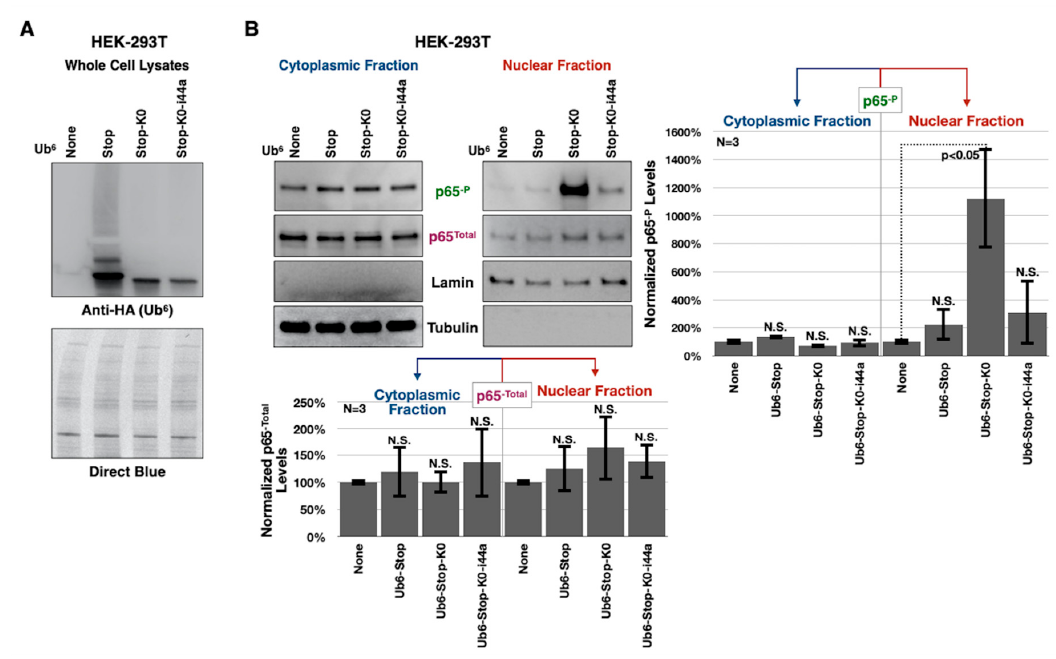
Figure 7. Isoleucine 44 mediates nuclear translocation of phosphorylated p65 in mammalian cells. ( A ) Western blots from whole-cell lysates of HEK-293T cells transfected with empty vector or Ub 6 plasmids. ( B ) Western blots and quantifications from cytoplasmic / nuclear fractionation of HEK-293T cells transfected as in ( A ). For both ( A , B ), results are representative of three independent experiments. In panel ( B ), p65 protein levels were quantified, divided by the respective loading control (tubulin or lamin) for each fraction and normalized to controls lacking Ub 6 . Shown in histograms are means ± standard deviation. ‘ p ’ value is from Student’s t -tests comparing cells expressing Ub 6 to non-Ub 6 -expressing controls. “N.S.” denotes no statistical significance comparing a specific Ub 6 group to its respective control. p65 -P : phosphorylated-p65. The COVID-19 situation also hampered our ability to conduct additional cell-based